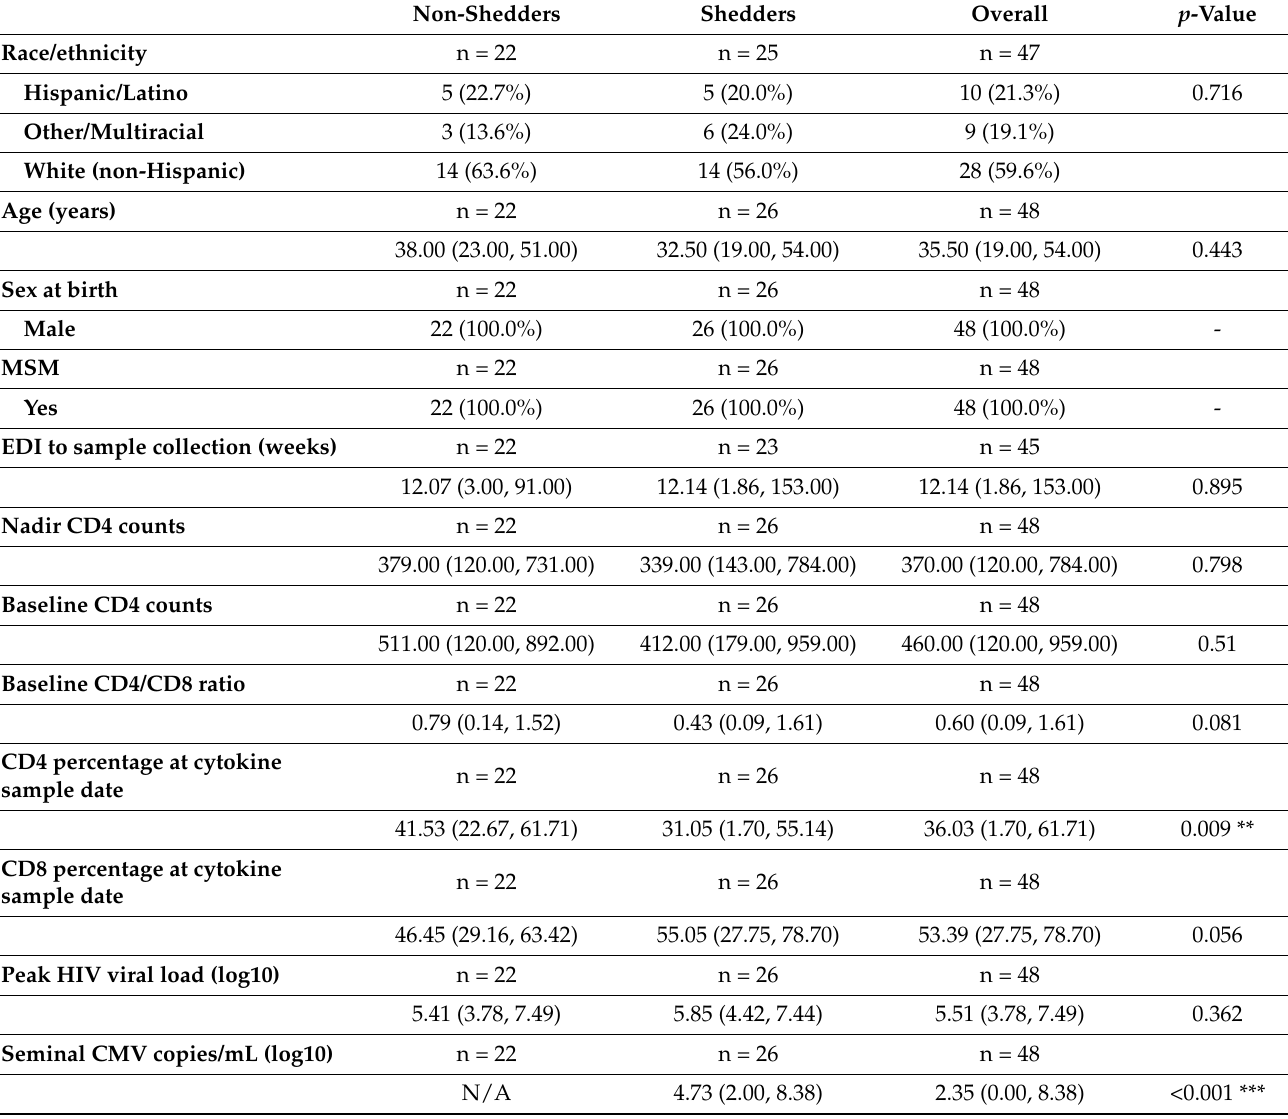
Table 2. Demographic and clinical information: CMV shedders vs. non-shedders.